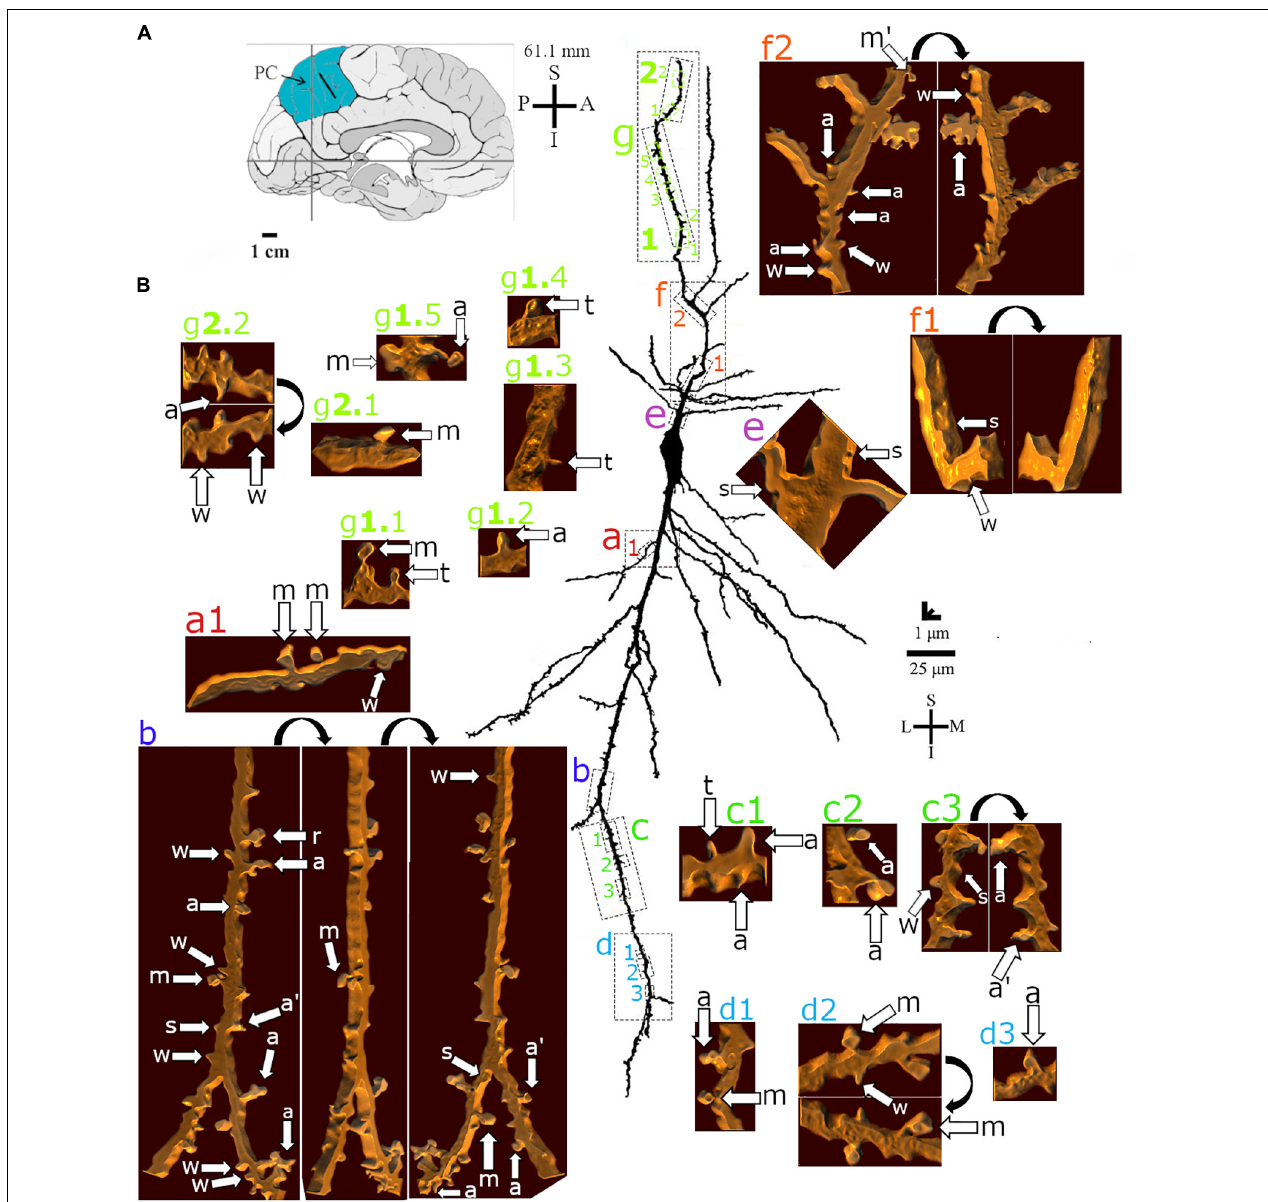
FIGURE 7 | (A) Left: Schematic drawing of the medial view of the human brain showing the location of the precuneus (PC, highlighted in blue), central region, 61.1 mm posterior to the midpoint of the anterior commissure. Adapted from Mai et al. (2008, 2016). (B) Two-dimensional (for the overall shape) and 3D (for the dendritic and spine details) image reconstructions of serial brightfield photomicrographs of a Golgi-impregnated spindle-shaped neuron in the layer V in transition to layer VI in the human PC (pial surface at the top). Note the cell body shape, the main ascending and descending primary dendrites with more profuse branching points and radial ramifications. Proximal to distal dendritic segments (identified by colored letters from “a” to “g”) were sampled and their spines are shown at higher magnification in the adjacent corresponding boxes. Note the distribution of low to moderate density of spines as well as the variety of their shapes. Spines were classified as stubby (s), wide (w), thin (t), mushroom (m), ramified (r), with a transitional (t), or atypical aspect (a). Dendritic segments and spine types are indicated at different rotating angles. An apostrophe with the corresponding spine indicates the presence of a spinule. Image adjustment of contrast made with Photoshop CS3 (Adobe Systems, Inc., United States). Coordinates in (A,B) : I, inferior; L, lateral; M, medial; S, superior. Scale = 25 µ m for the 2D reconstruction and 1 µ m for the 3D